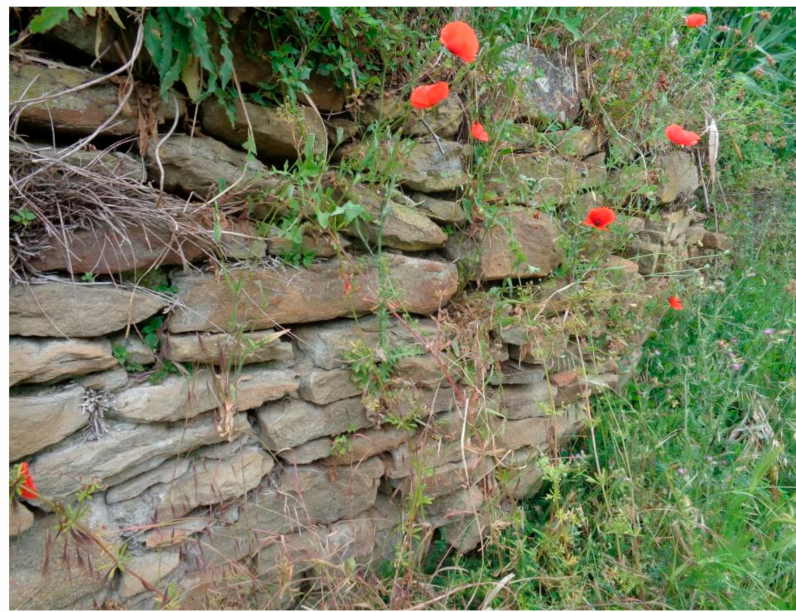
Figure A4. Damage class 4—Whole wall bulging,